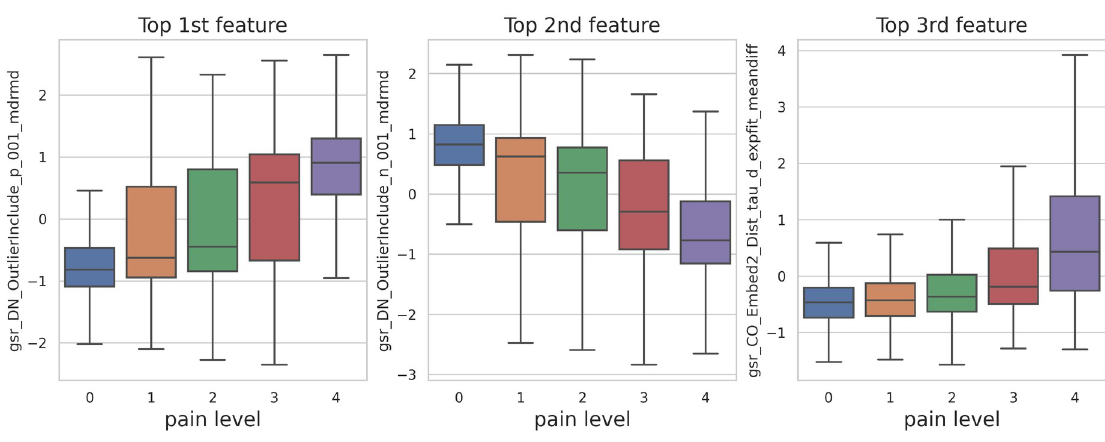
Fig 3. Top 3 EDA features per pain levels.